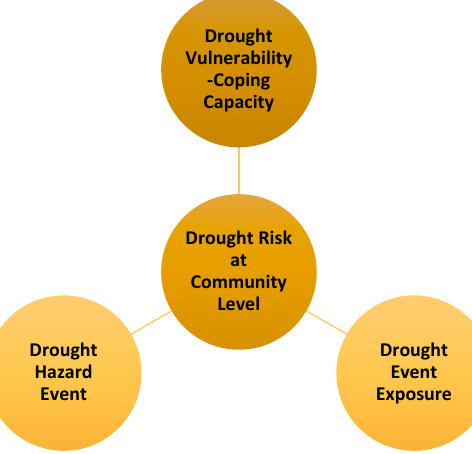
Figure 1. Drought risk vulnerability realm.